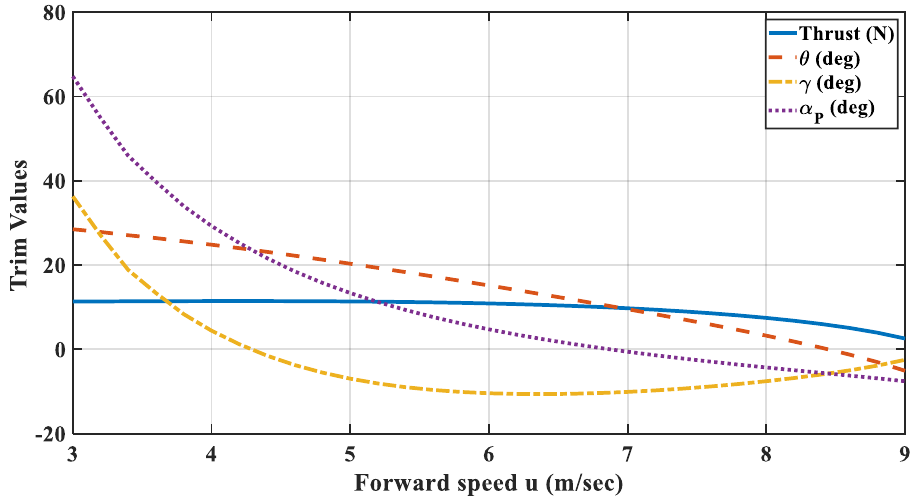
Figure 7. Equilibrium operating points.